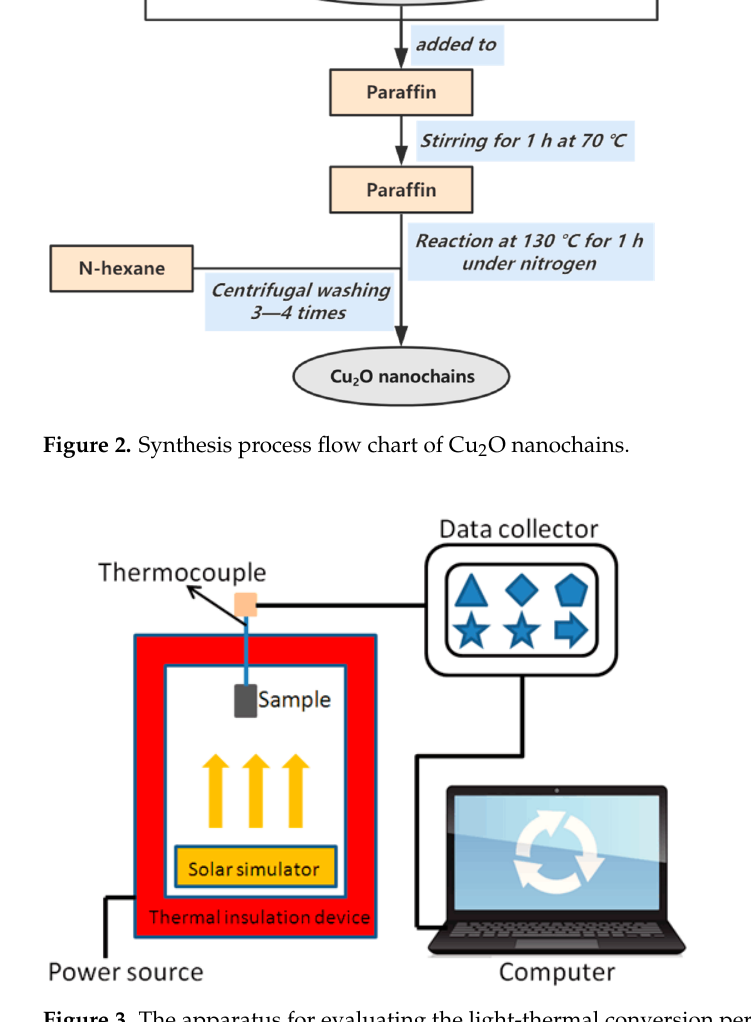
Figure 4. XRD pattern of Cu 2 O nanochains.